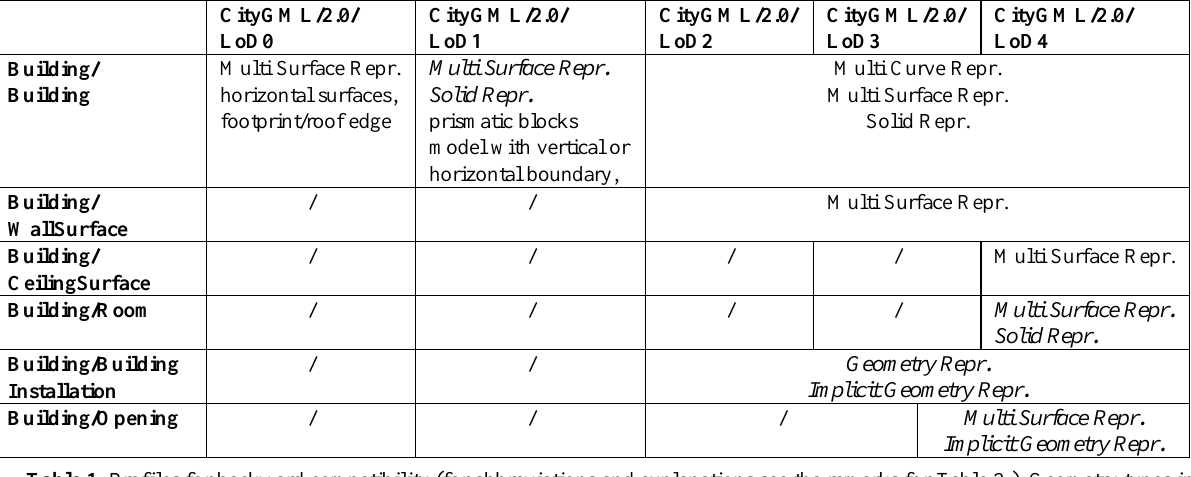
Figure 1. UML class diagram of the proposed multi representation concept as a CityGML 2.0 ADE.